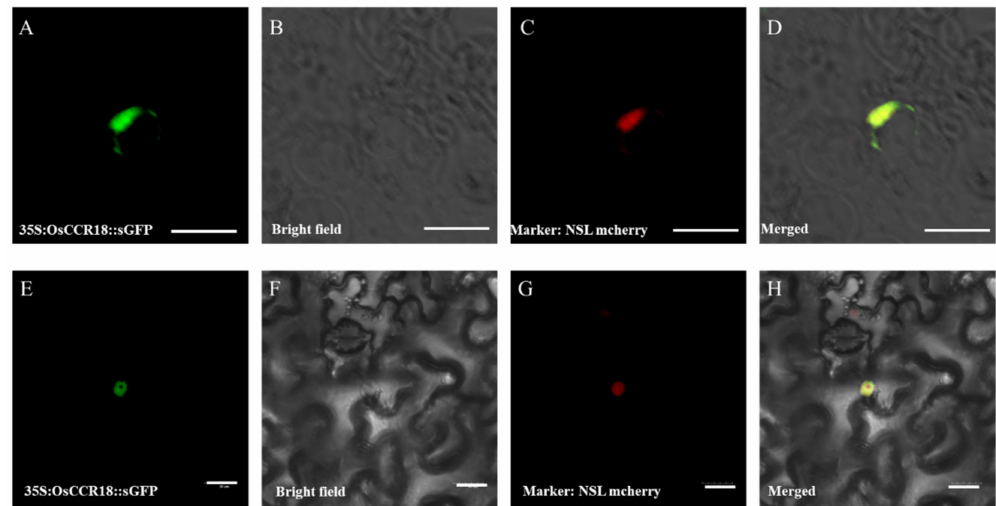
Figure 2. Subcellular localization analysis of OsCCR18 . ( A – D ) Transient expression of 35S : OsCCR18 :: sGFP fusion vector in rice protoplast. ( E – H ) Transient expression of 35S : OsCCR18 :: sGFP fusion vector in a tobacco leaf. In the experiment, the 35S : OsCCR18 :: sGFP plasmid was co– transformed with the nuclear localization marker NSL mCherry. Bar = 100 µ